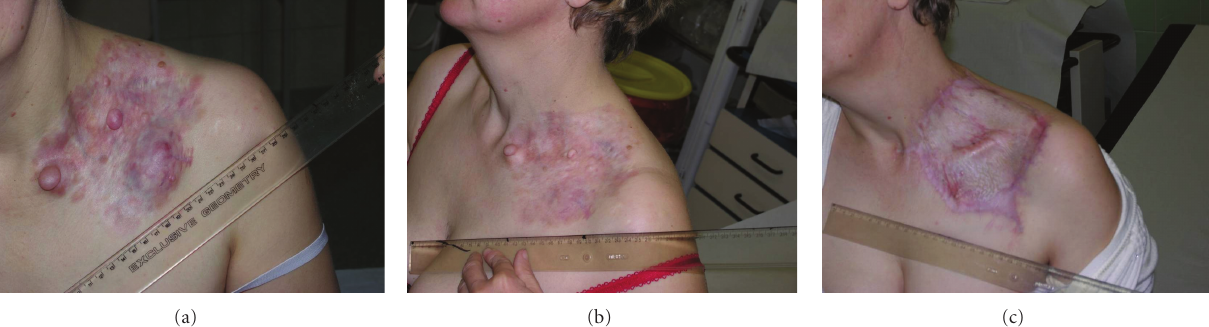
Figure 3: Images of advanced dermatofibrosarcoma protuberans of the supraclavicular region before and after therapy with imatinib, and after resection of residual disease. The patient is now 3 years free of disease.